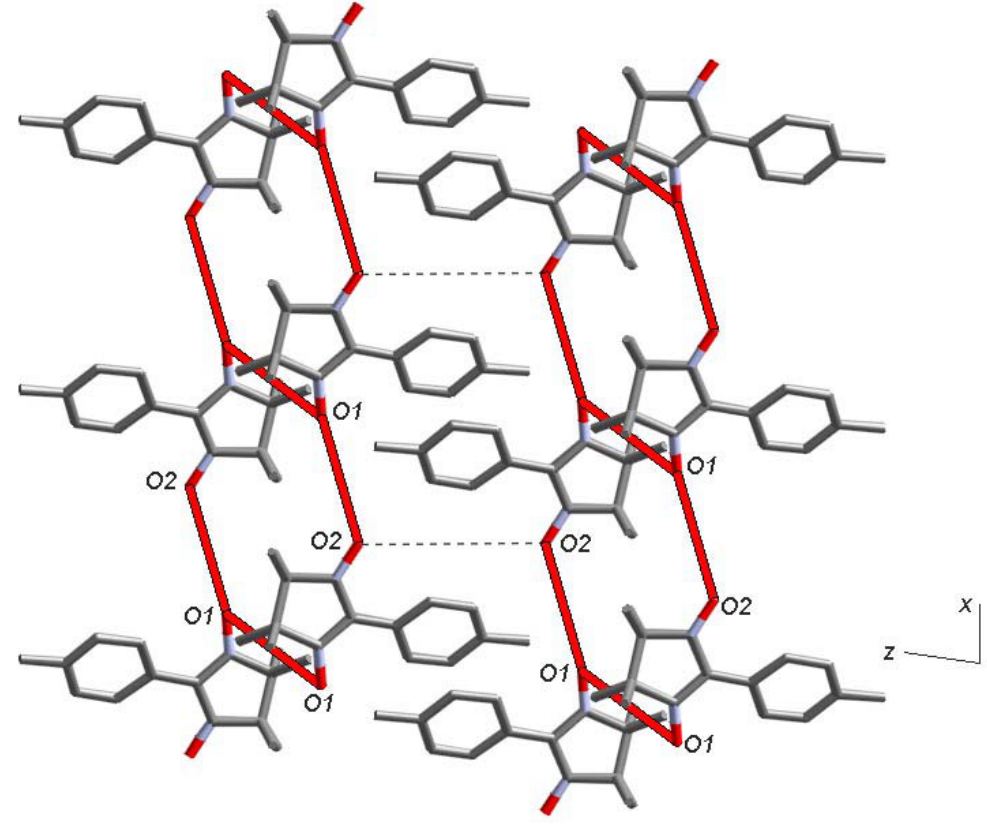
Figure 2. Projection of the crystal structure of 1 onto the ac plane. The spin ladder system is shown by red rods. Dashed lines stand for interladder